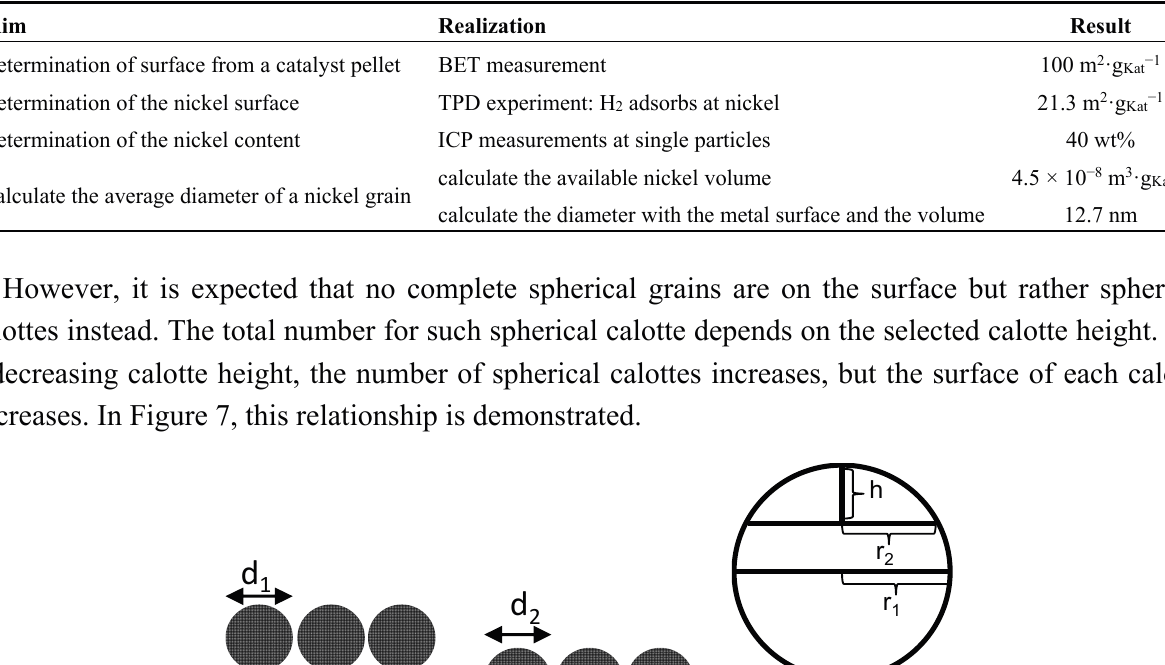
Table 1. Measured parameters and the resulting average diameter of the nickel spherical grains on the catalyst surface.